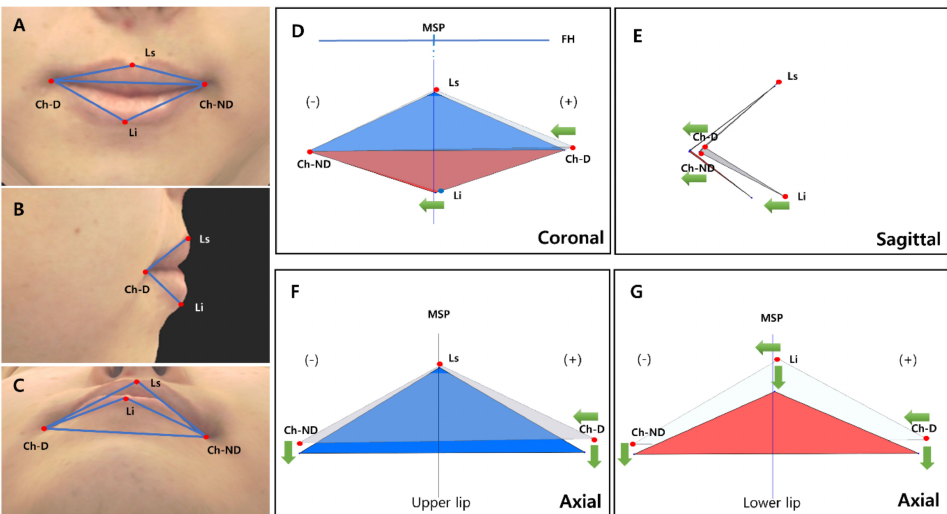
Figure 4. Changes in the upper and lower lip planes. The upper lip plane was established by connecting both sides of the Ch and Ls. The lower lip planes were also established by connecting both sides of the Ch and Li. ( A – C ) The lip planes on the FS images, ( D ) The coronal view of the lip planes, ( E ) The sagittal view of the lip planes, ( F ) The axial view of the upper lip plane, ( G ) The axial view of the lower lip plane. Green arrows indicate significant changes in the landmarks. MSP, midsagittal plane; FH, Frankfort horizontal plane; Ls, labrale superius; Ch-D/ND, cheilion on deviated side/non-deviated side; Li, labrale inferius; and Ls, labrale